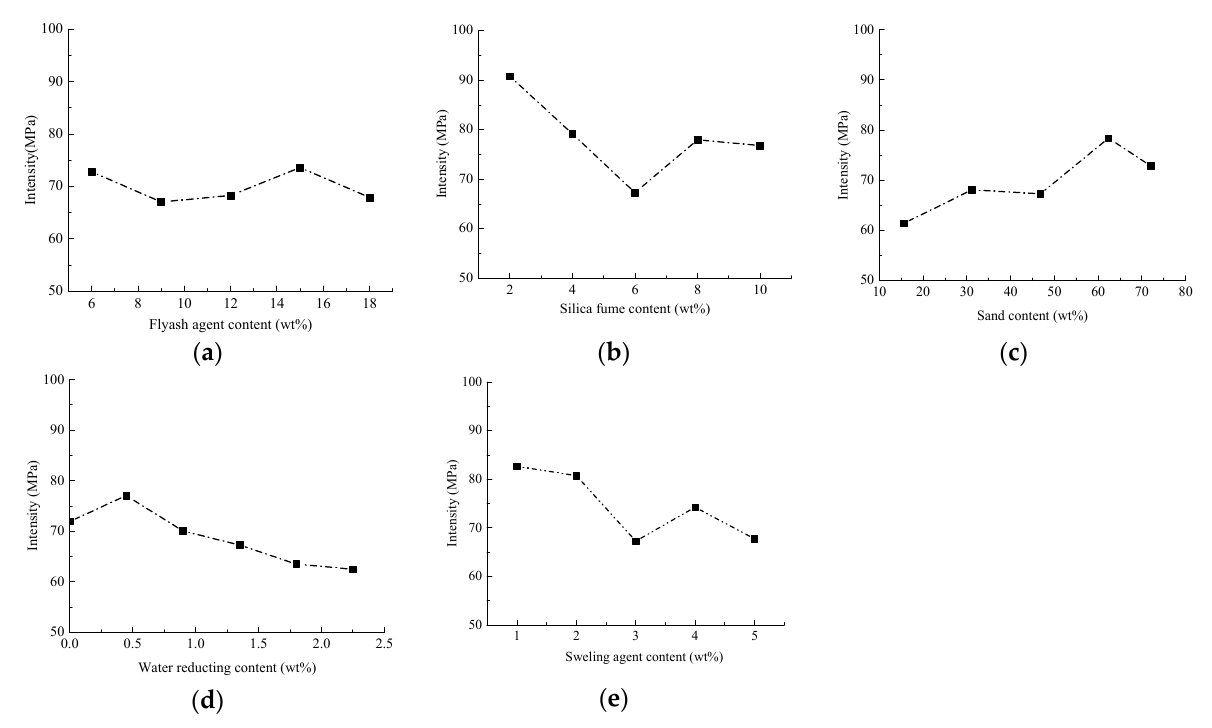
Figure 8. The influence of the content of different components on the compressive strength ( a ): fly ash; ( b ) silica fume; ( c ) sand; ( d ) water reducing agent; ( e ) expansion agent.